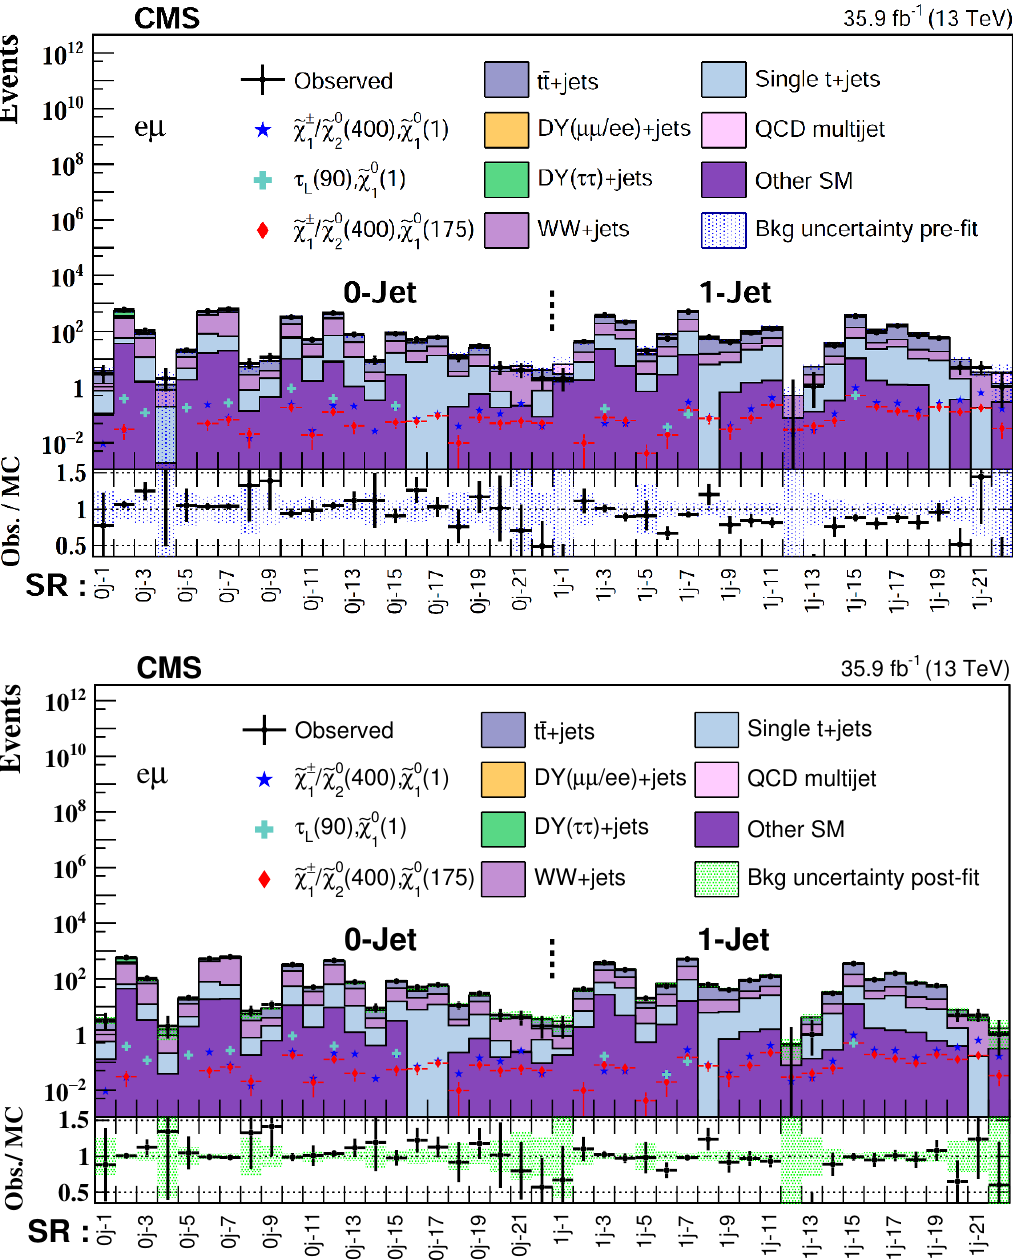
Figure 10. Pre-(cid:12)t (upper) and post-(cid:12)t (lower) results for the SRs used for the (cid:12)nal signal extraction in the e (cid:22) (cid:12)nal state. Distributions for two benchmark models of chargino-neutralino production, and one of direct left-handed (cid:28) pair production, are overlaid. The numbers within parentheses in the legend correspond to the masses of the parent SUSY particle and the (cid:31) 0 in GeV for these 1 benchmark models. In the ratio panels, the black markers indicate the ratio of the observed data e in each SR to the corresponding pre-(cid:12)t or post-(cid:12)t SM background prediction. e